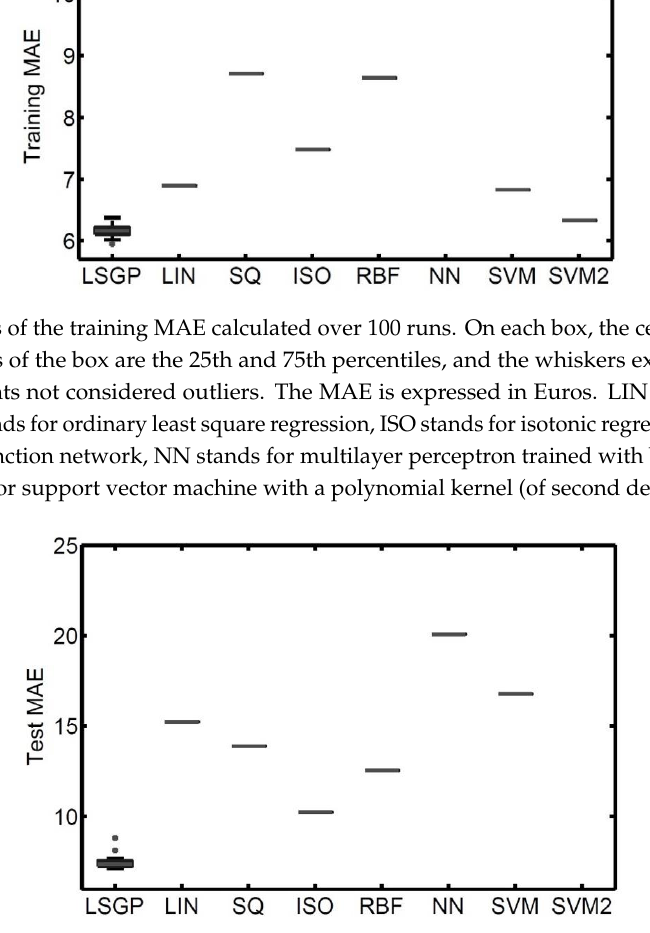
Figure 5. Boxplots of the test MAE calculated over 100 runs. On each box, the central mark is the median, the edges of the box are the 25th and 75th percentiles, and the whiskers extend to the most extreme data points not considered outliers. The MAE is expressed in Euros. LIN stands for linear regression, SQ stands for ordinary least square regression, ISO stands for isotonic regression, RBF stands for radial basis function network, NN stands for multilayer perceptron trained with backpropagation, and SVM stands for support vector machine with a polynomial kernel (of second degree for SVM2).